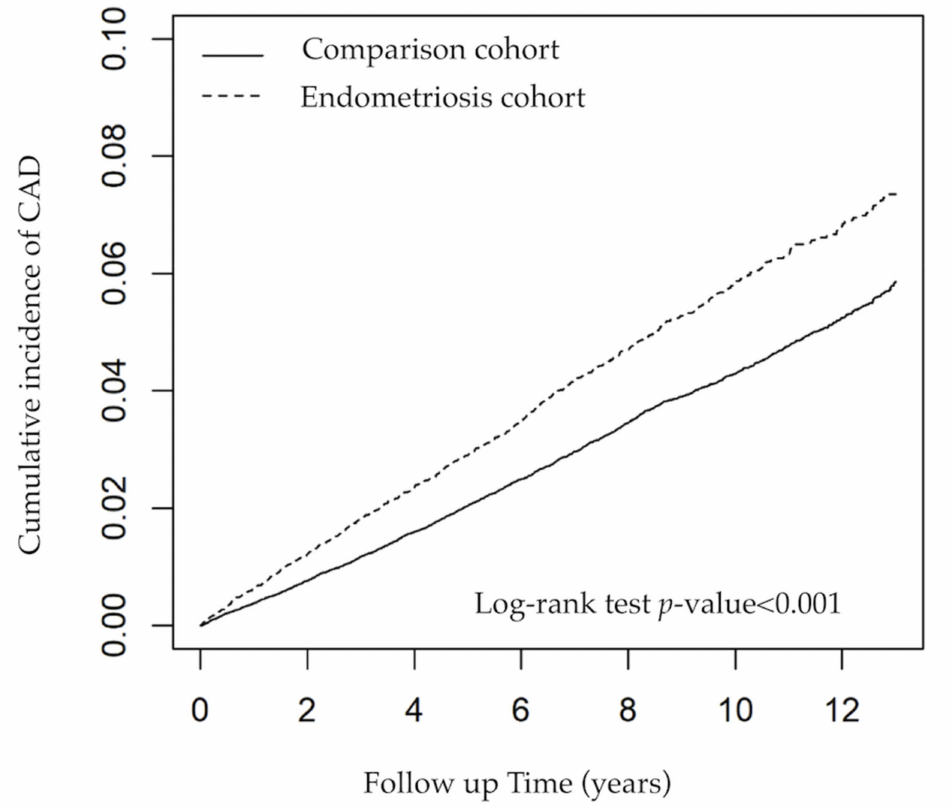
Figure 1. Kaplan–Meier analysis with unadjusted cumulative incidence curves of CAD for en- dometriosis cohort and comparison